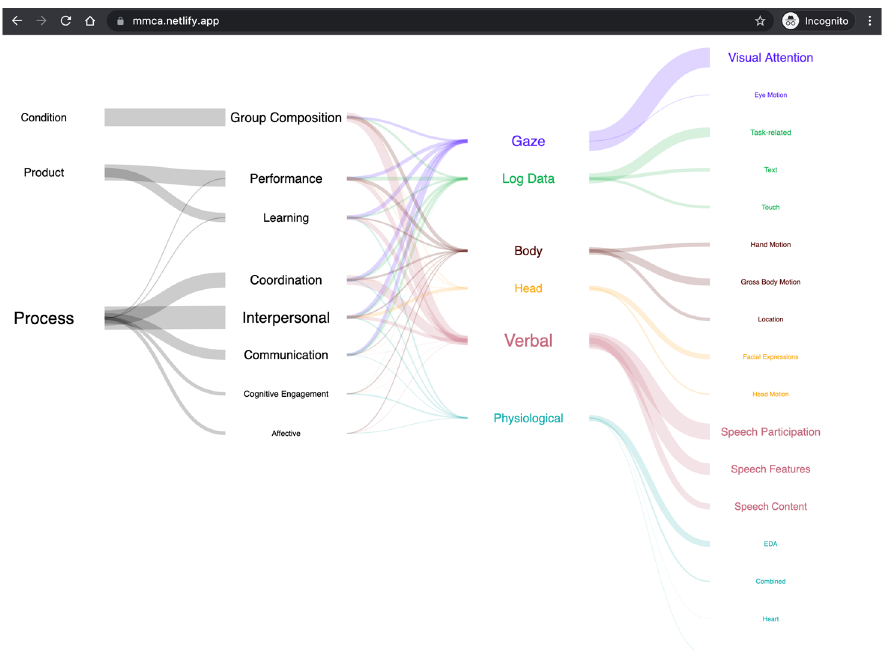
Figure 4. The Multimodal Collaboration Analytics (MMCA) website.